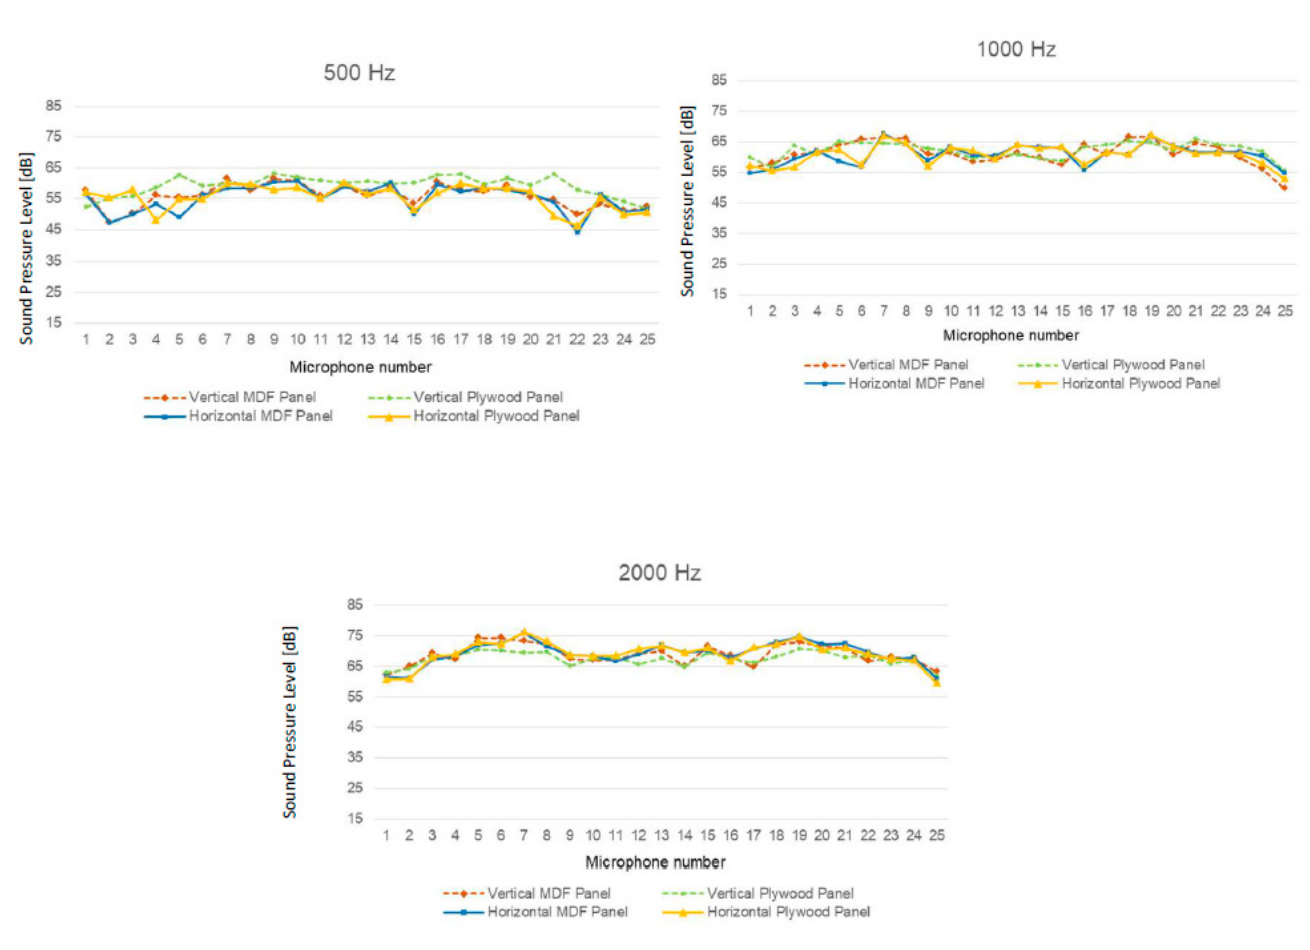
Figure 8. Results for the four panel’s configurations tested inside Room A at